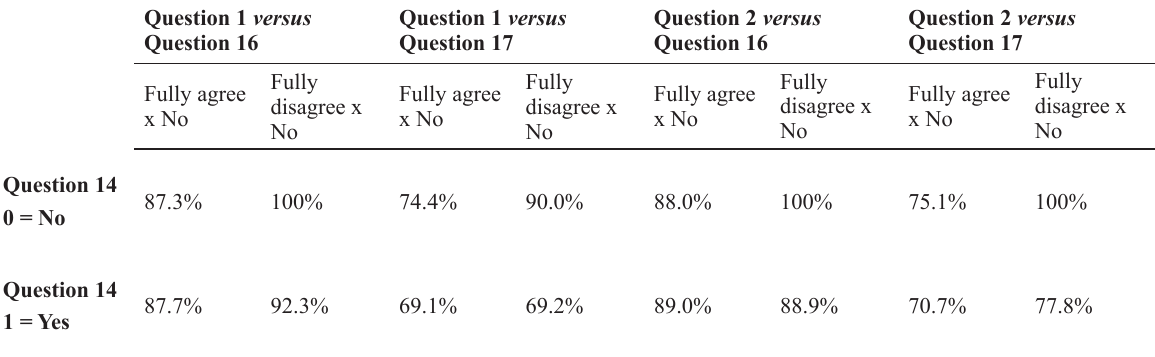
Larger percentage verified for respondents who marked “fully agree” and “fully disagree” (Question 1 and Question 2) versus “no” (Question 16 and Question 17) crossed with the responses to Question 14 according to those who marked item 6 (0 = no) and those who marked item 6 (1 = yes).